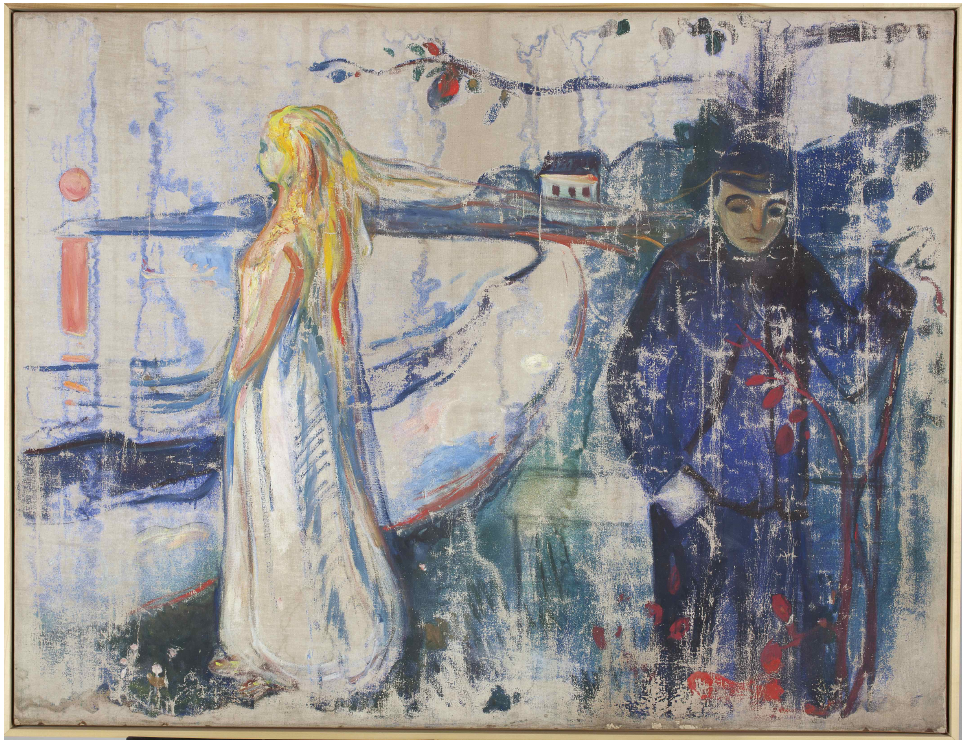
Figure 8: Separation (1894) ©